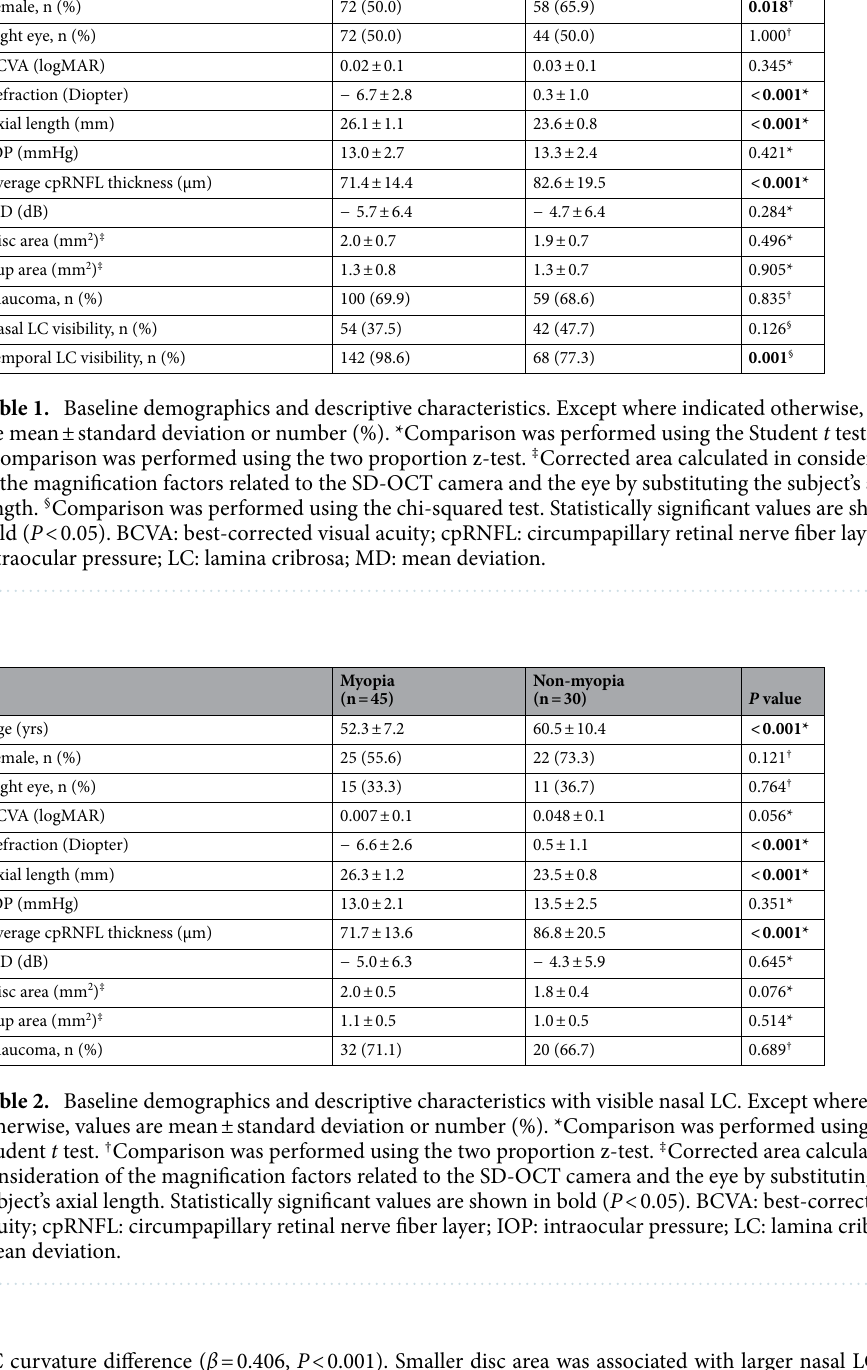
nasal LC. In the first row are the findings for the eye of a 51-year-old myopic female. The axial length was 26.1 mm and the refraction was − 7.0 D . The nasal LC curvature was 1.80 (1/mm) and the temporal LC curvature LC curvature was 1.75 (1/mm).